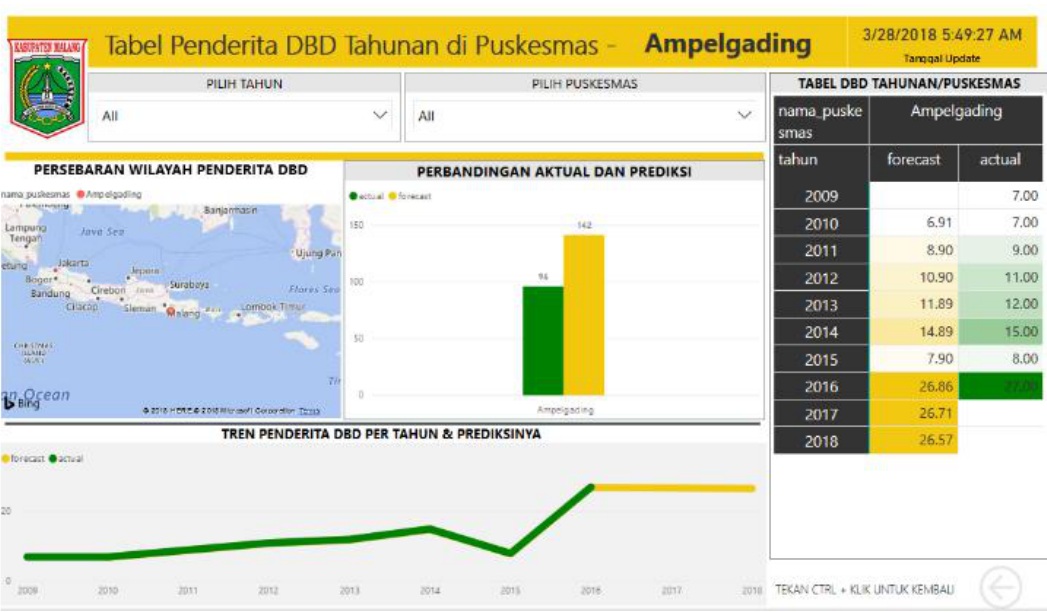
Fig. 7 Dengue Fever Patient Trends Per Year And Predictions In Line Graph